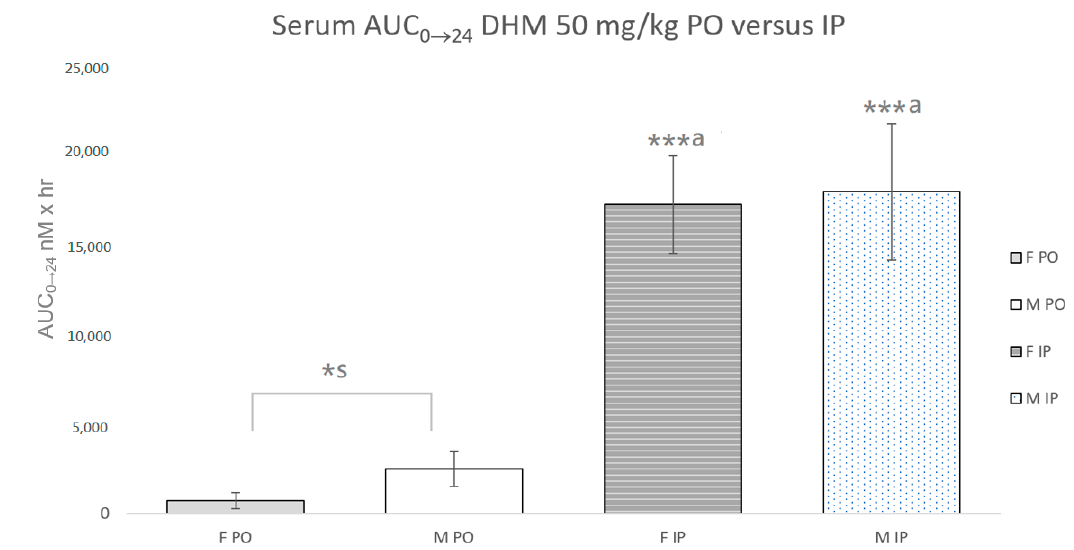
Figure 2. Serum AUC0 → 24 of DHM 50 mg/kg with oral (PO) and intraperitoneal (IP) administration in male and female mice. * s Statistically significant ( p < 0.05) difference between male and female mice. *** a Statistically significant ( p < 0.0001) between administration routes of same sex.